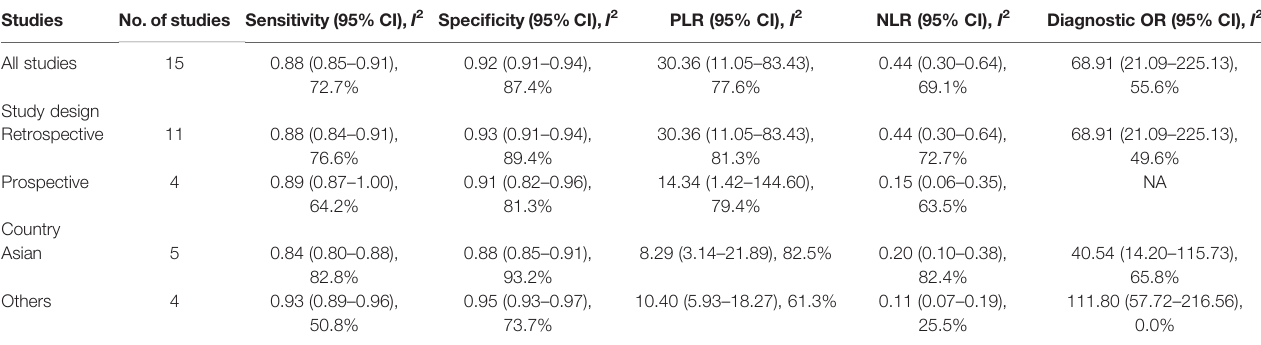
TABLE 3 | Subgroup analyses of the diagnostic performance of